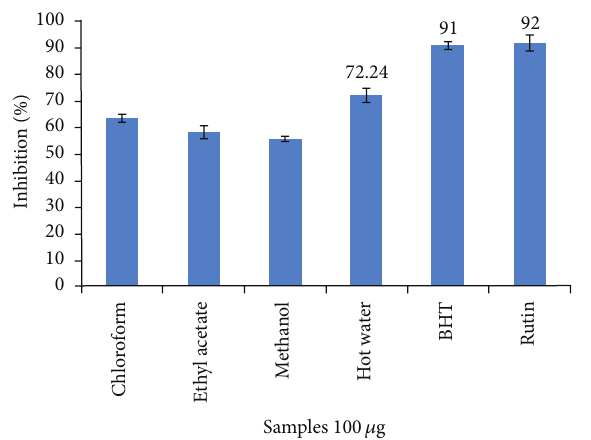
Figure 3: Superoxide radical scavenging activity of leaf extract of C. dipsaceus . Values are mean of triplicate determination (𝑛 = 3) ± standard